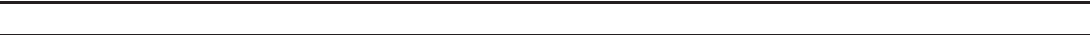
Table 2. Elena, her mother and sister